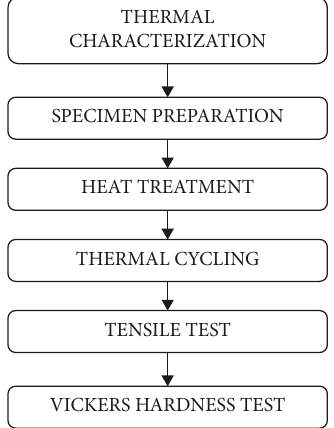
Figure 1: Flowchart of the experimentation